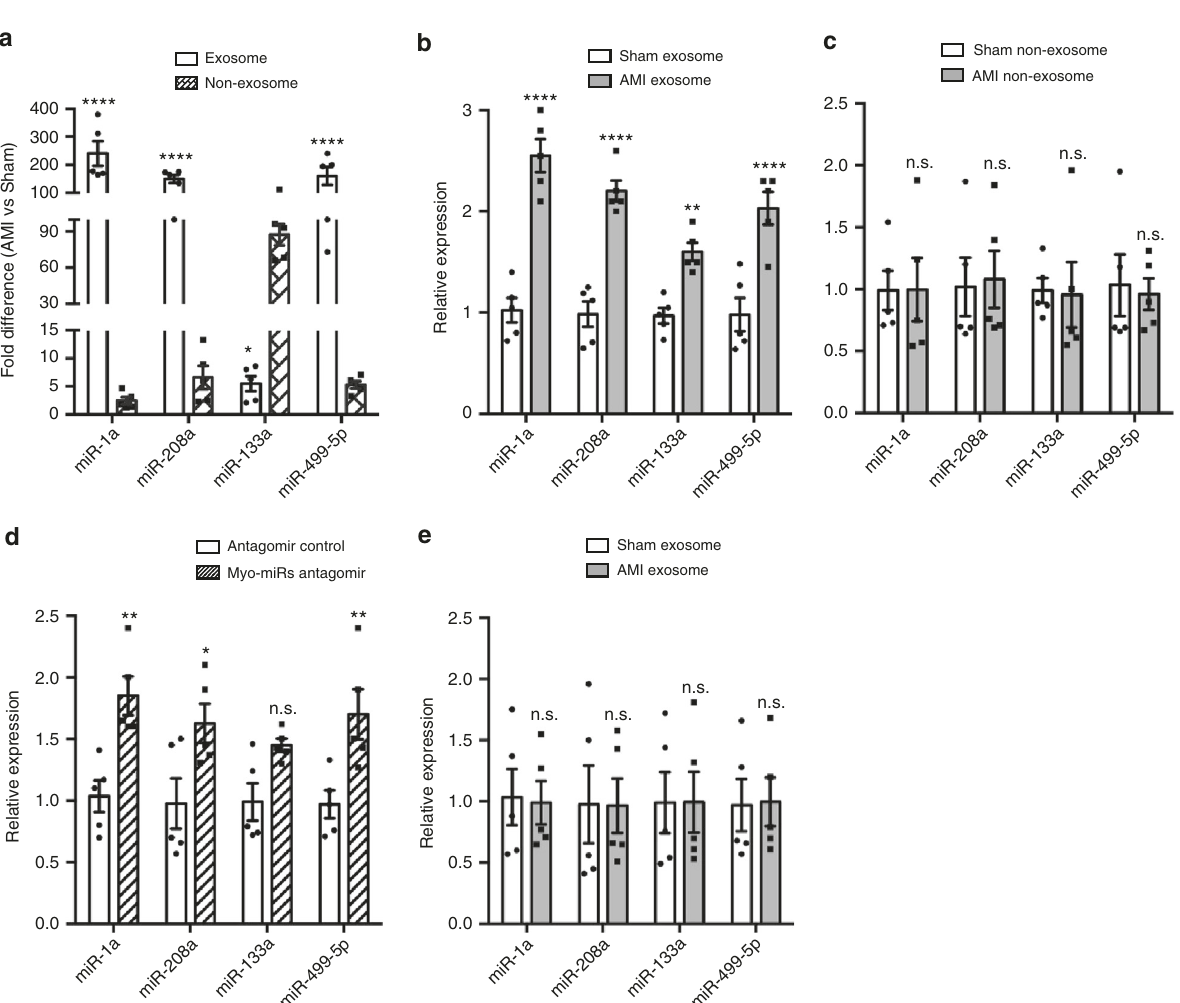
24 h. The expression of CXCR4 was signi fi cantly reduced in BM-